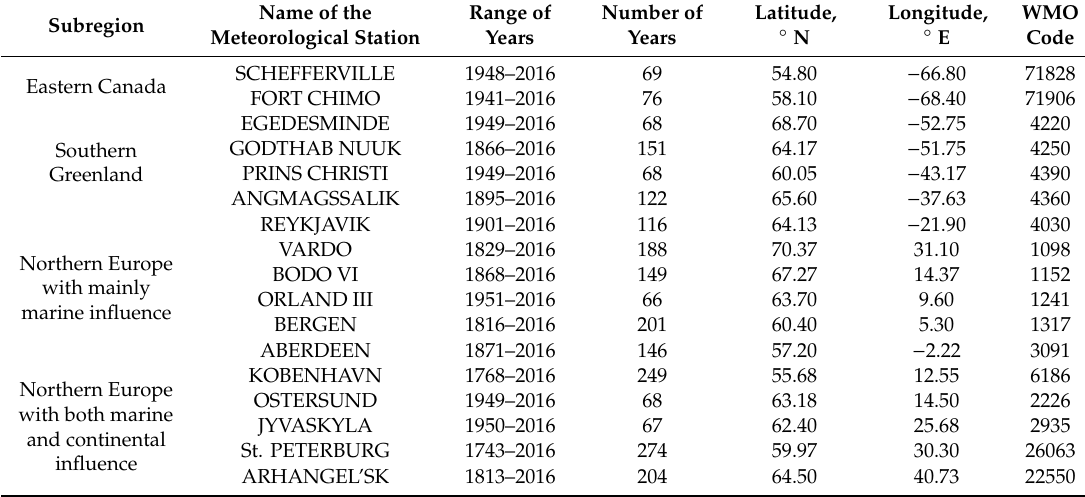
Table 1. The length of the surface air temperature (SAT) time series at the meteorological stations in the North Atlantic